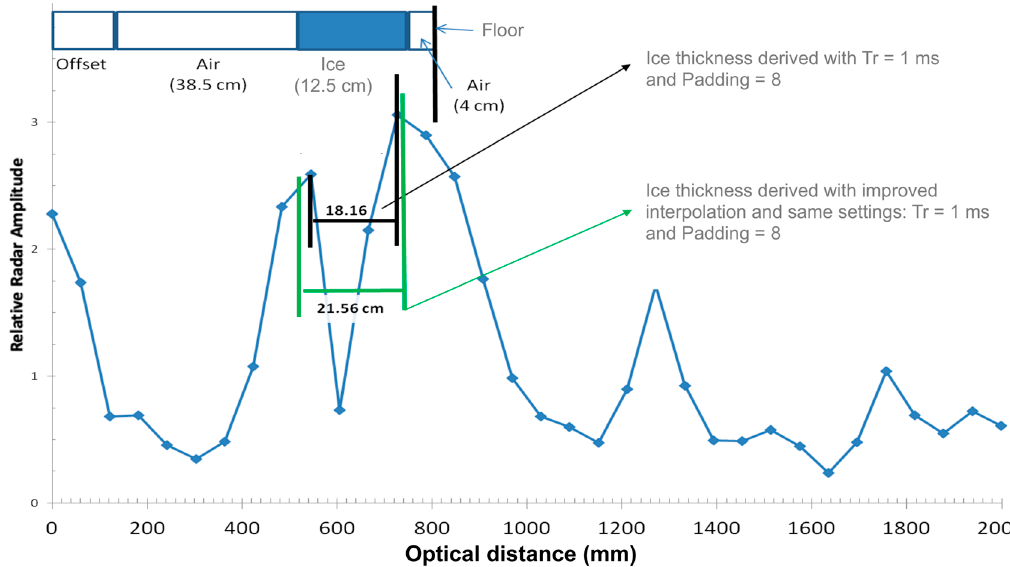
Figure 4. Laboratory test performance on improved processing of FMCW radar signal to estimate ice thickness with a 12.5 cm block of ice measured from a distance of 38.5 cm (see text).